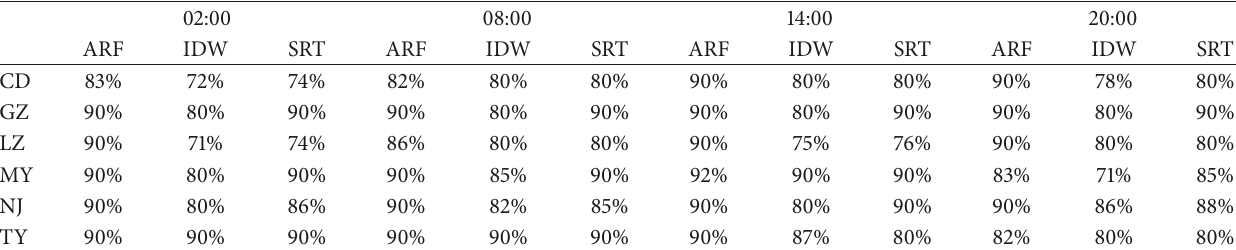
Table 2: The detection rate under optimal QC parameters for CD, GZ, LZ, MY, NJ, and TY at 02:00, 08:00, 14:00, and